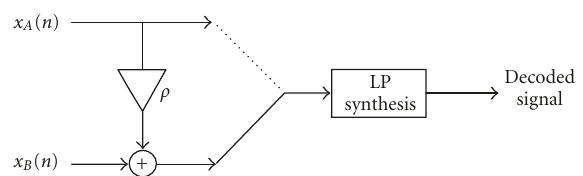
Figure 6: Scheme of the decoder including the mixing